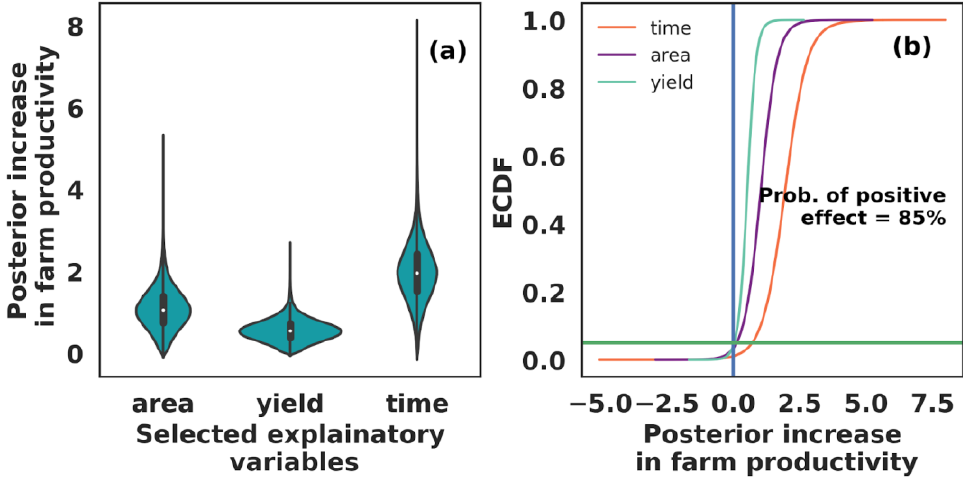
Figure 5. Distribution of posterior marginal effects size of explanatory variables used in the Bayesian model. ( a ) The violin plot shows the distribution of the complete data and the white dot represents the mean effect with 94% confidence. ( b ) The empirical cumulative distribution functions (ECDF) of the three variables with the corresponding probability of having a positive effect on farm